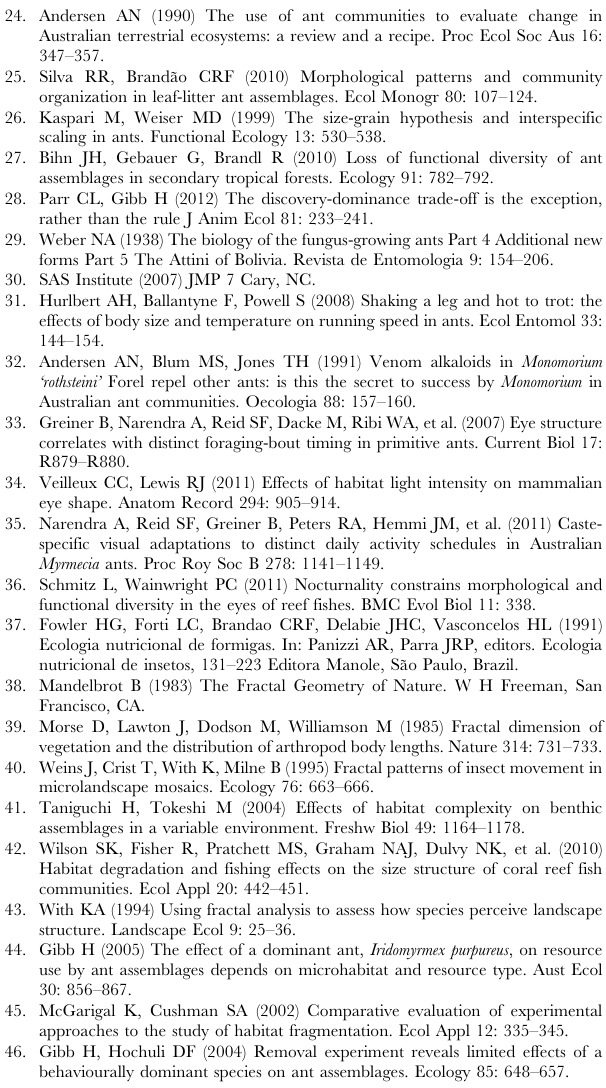
Table S2 Occurrence of species at baits after 3 hours in complex and simple natural habitats in each of the regions. Abbreviations for morphological traits are: WL: Weber’s length; HL: